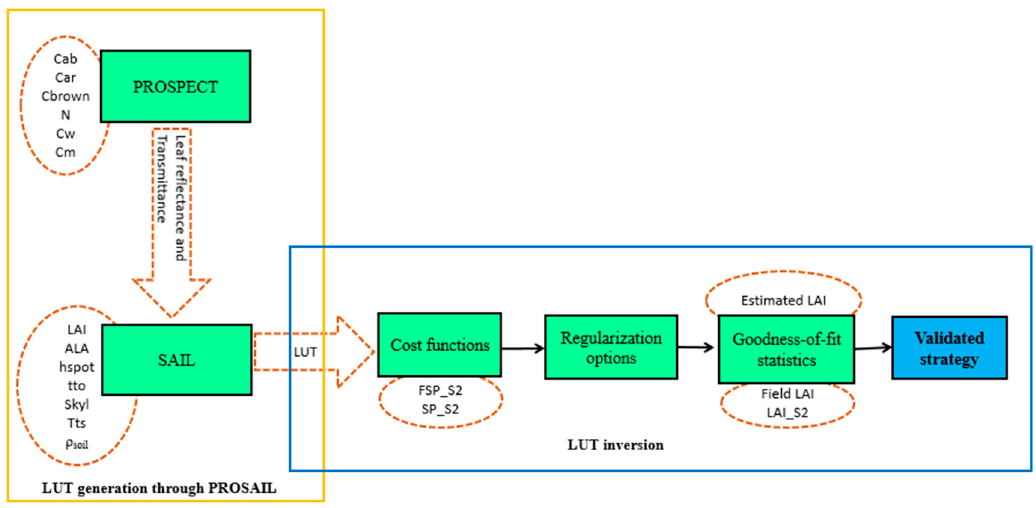
Figure 4. Look-up table (LUT) generation through PROSAIL and LUT inversion process for LAI retrieval.